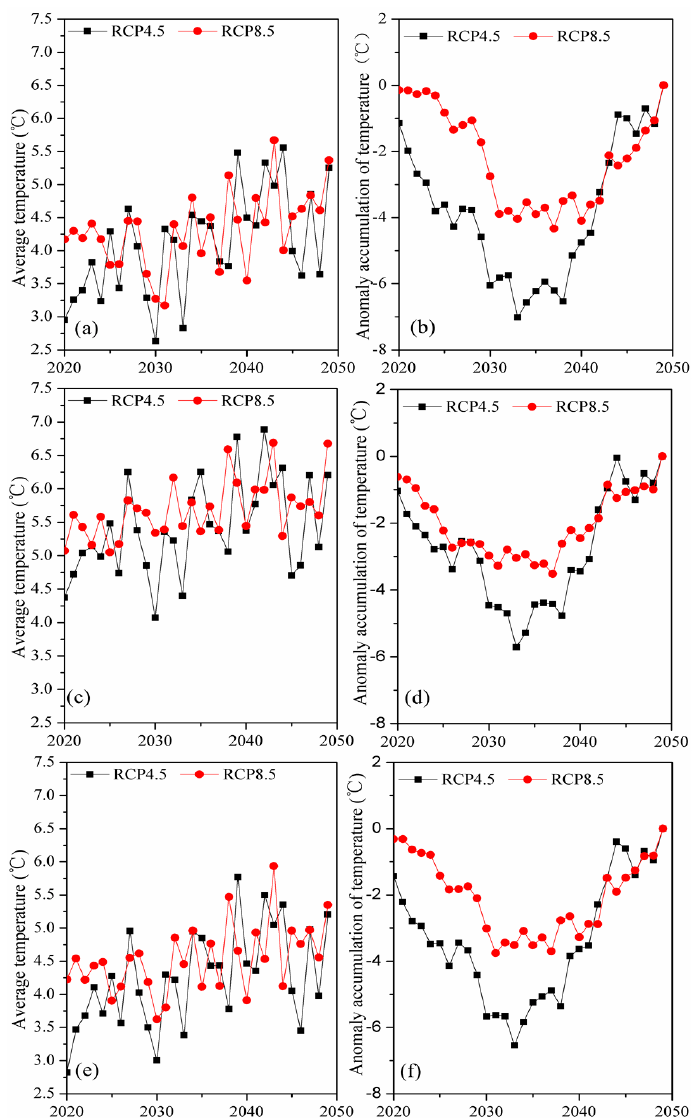
Figure 4. The inter ‐ annual variation and anomaly accumulation of temperature in Nenjiang River ( a , Figure 4. The inter-annual variation and anomaly accumulation of temperature in Nenjiang River b ), Upper Songhua River ( c , d ), and Lower Songhua River ( e , f ) sub ‐ basins of the Songhua River ( a , b ), Upper Songhua River ( c , d ), and Lower Songhua River ( e , f ) sub-basins of the Songhua